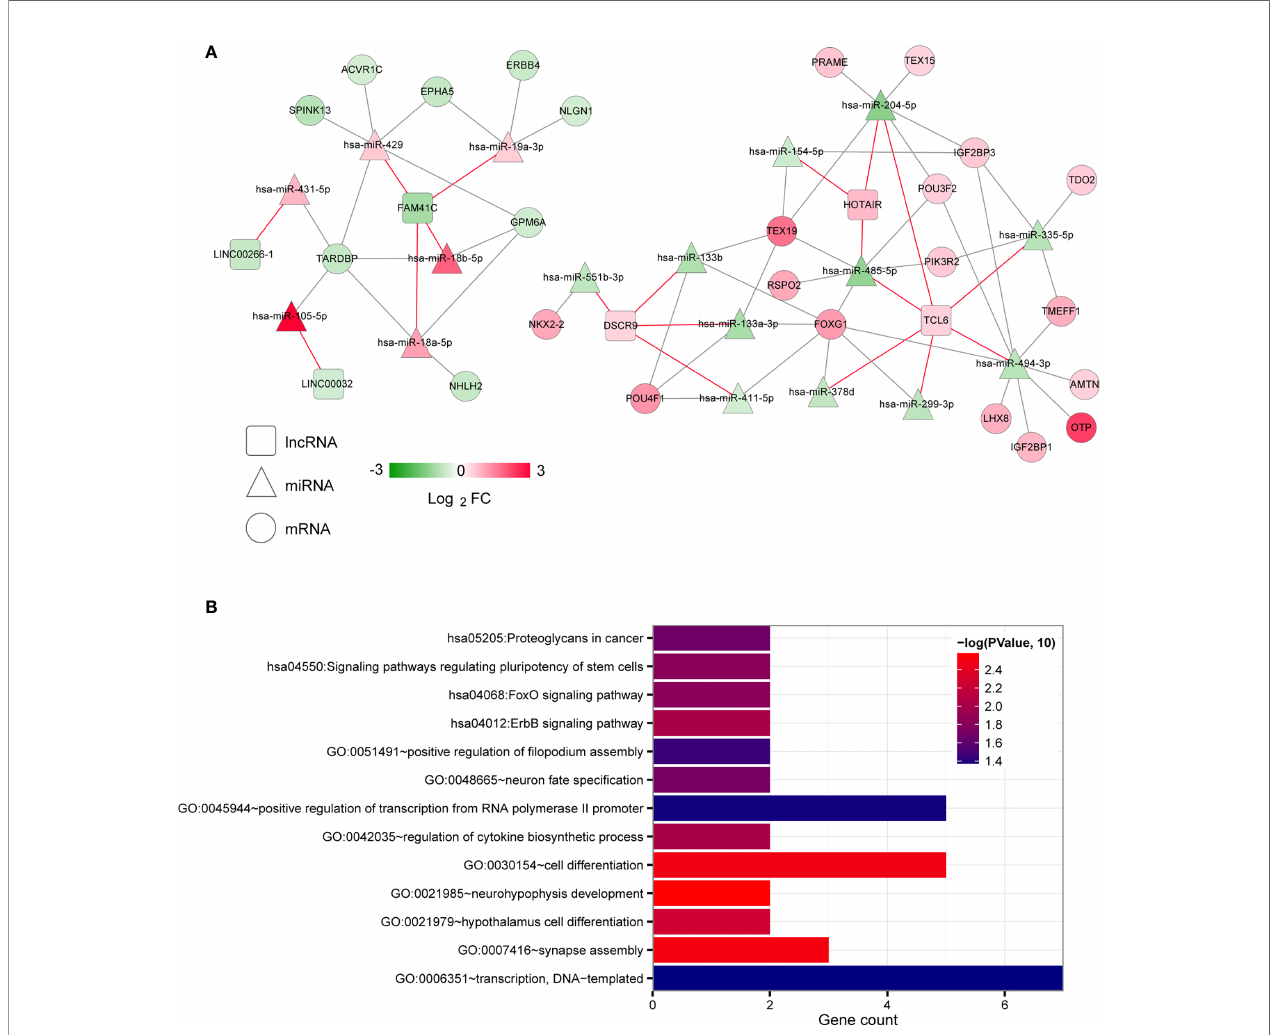
FIGURE 2 | Targeted ceRNA regulatory network. (A) The mutual targeting relationships among lncRNAs, miRNAs and mRNAs. The colour change from green to red indicates a change from low to high. The red and grey lines indicate the DElncRNA-DEmiRNA associations and the DEmiRNA-DEmRNA regulatory associations, respectively. (B) Bar diagram of the GO biological processes and KEGG signalling pathways signi fi cantly correlated with mRNAs in the ceRNA network. The horizontal axis shows the number of genes. The vertical axis shows the entry names. Entries closer to a red colour are more signi fi